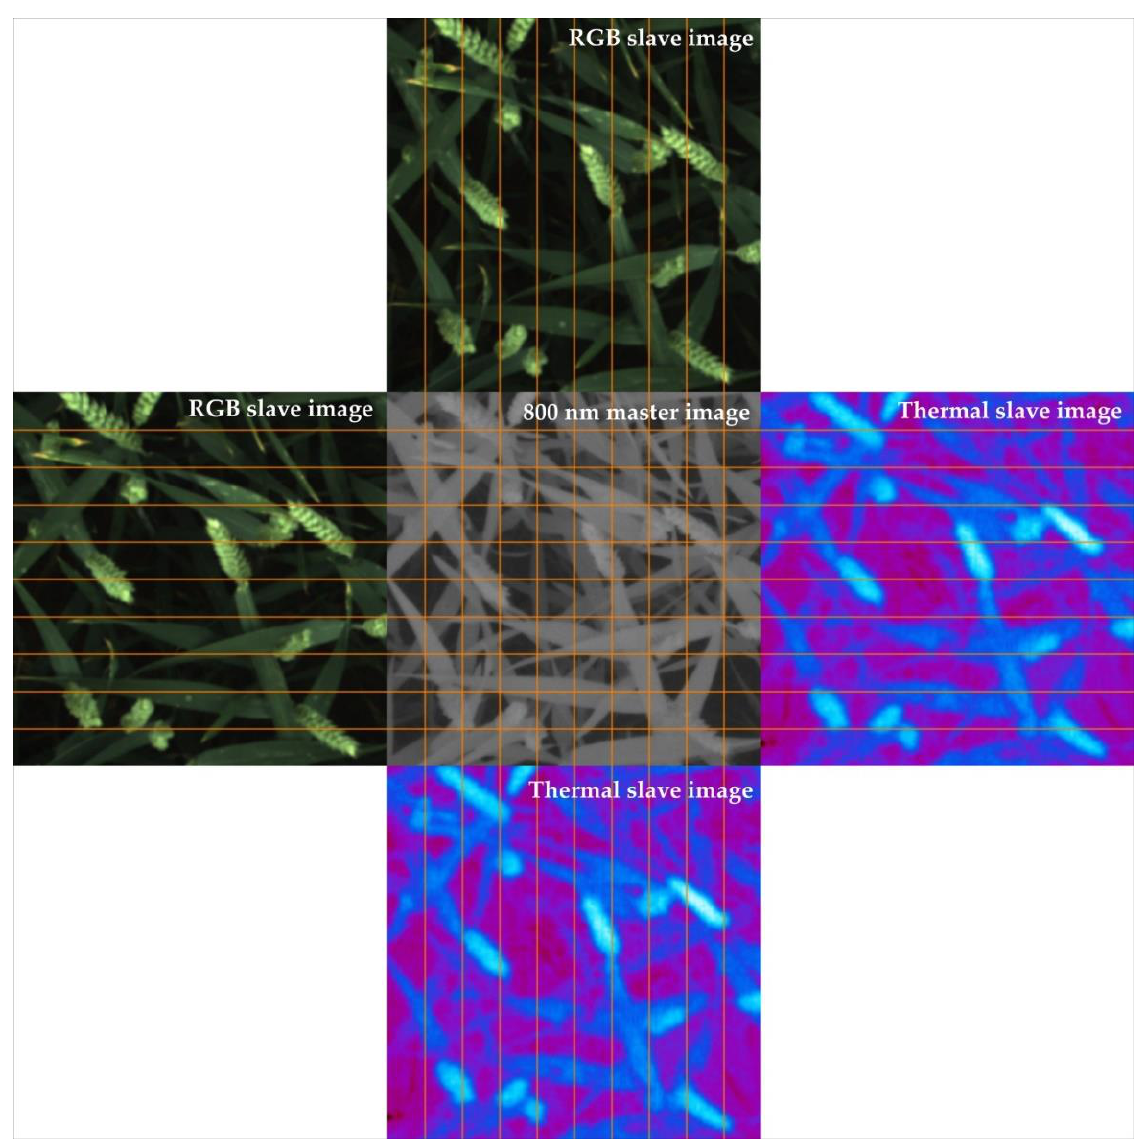
Figure 14. Visualization of image registration quality for RGB and thermal slave images aligned using the ECC method. Orange lines are markers dedicated to ease image comparison. Color and contrast of the master image have been adjusted to increase plant organs visibility.